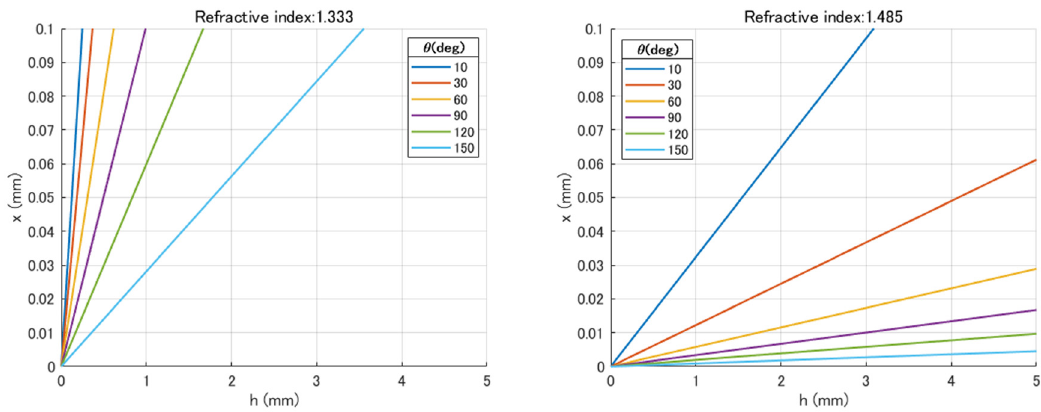
Figure3. Relationshipbetweendistancefromtherefractivepointtotheskin(h)andopticalmisalignment (x) when using silicone oil (left) and water (right). Each line in the graph shows the relationship when the texture angle is